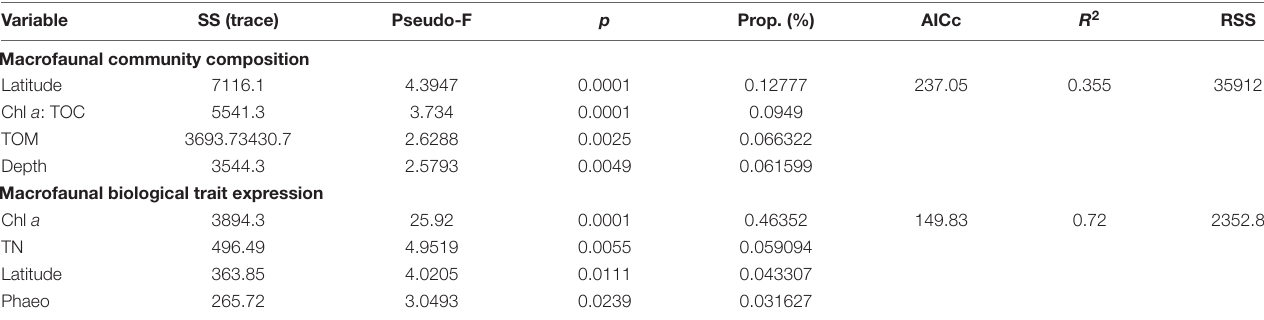
Table includes sequential tests results for each variable: SS(trace) (portion of sum of squares relative to the analyzed predictor variable), Pseudo-F values, p-values, and Prop (proportion of variation explained by each variable), as well as AICc (Akaike Information Criteria corrected), R 2 (proportion of variation explained by the model), and RSS (Residual Sum of Squares) of the best